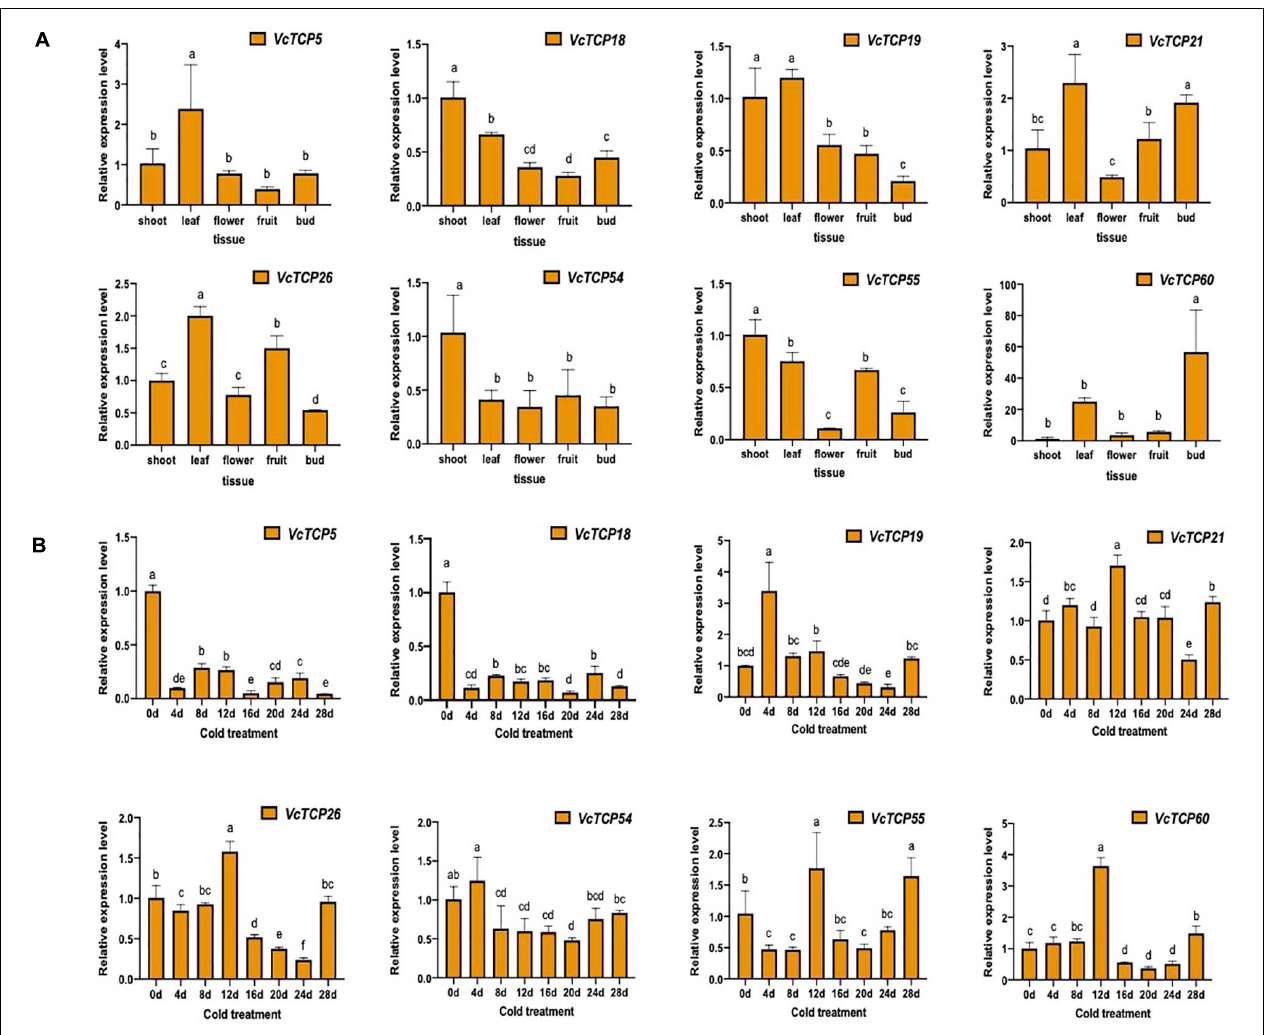
FIGURE 7 | (A) Relative expression levels of VcTCPs in different tissues of ‘O'Neal’ blueberry. (B) Relative expression levels of VcTCPs during flower bud endodormancy release by artificial chilling treatment. Values were normalized against the expression data of VcGAPDH and given as the means ± standard error of three biological replicates. Different letters indicate significant differences between genes ( p < 0.05 ) based on Duncan test. The expression levels were calculated based on the 2 − (cid:49)(cid:49) Ct